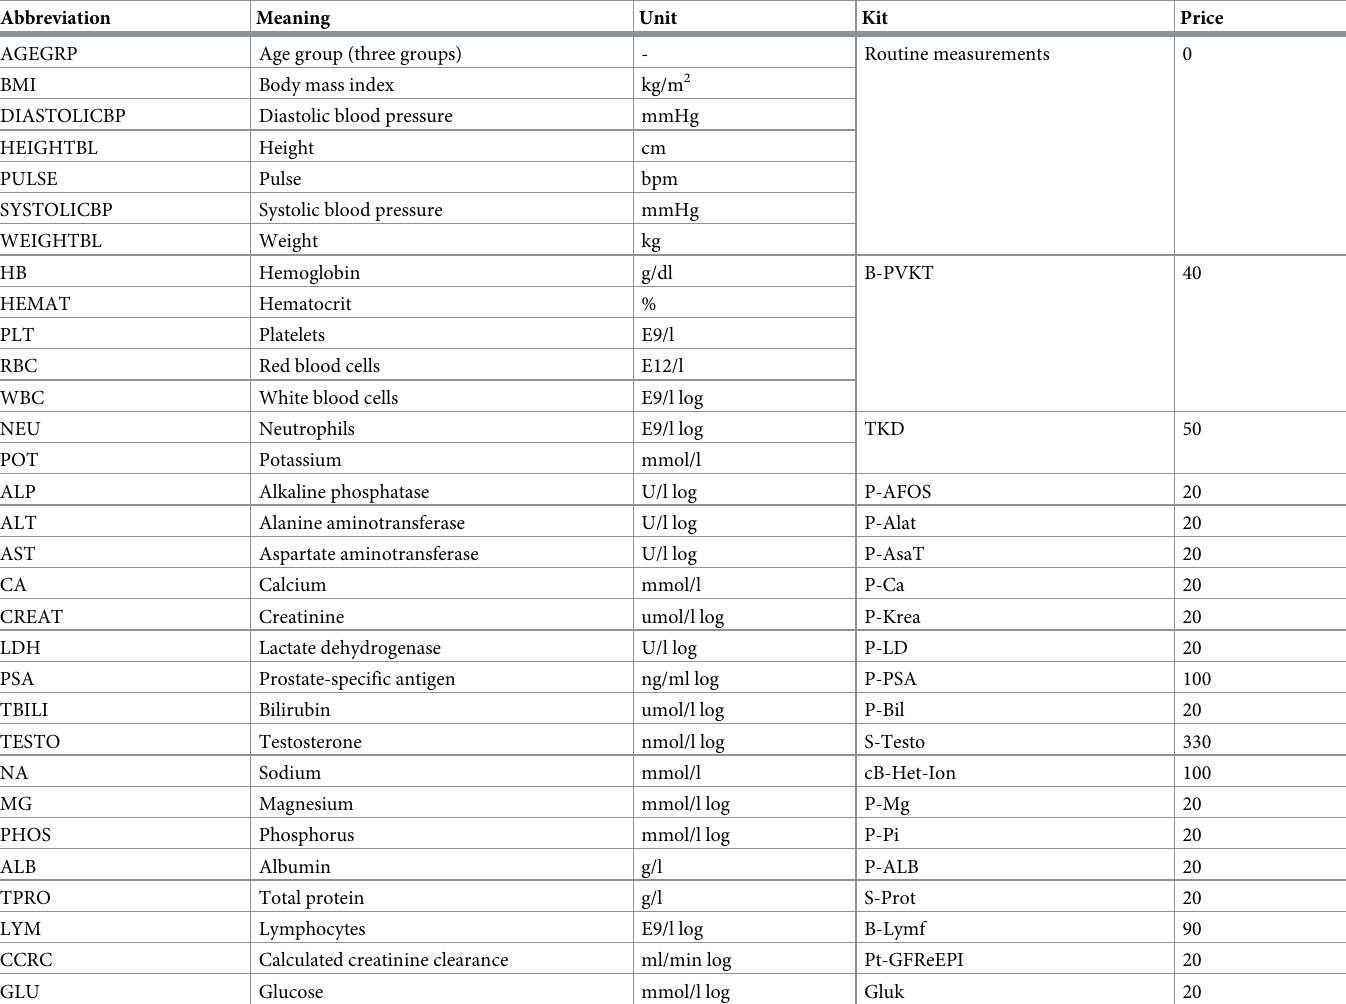
Table 1. Data features for the clinical cohort variables.